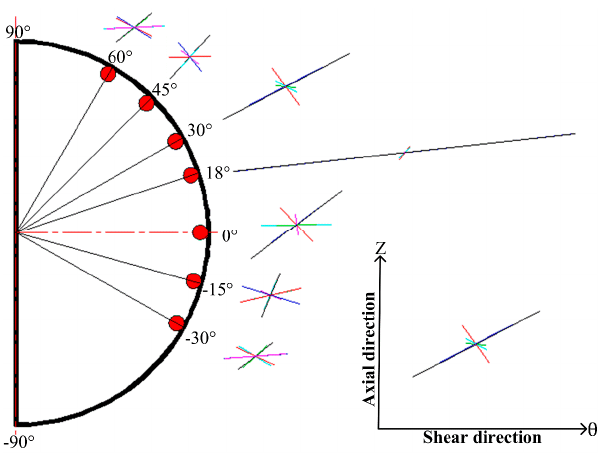
Figure 5. Slip traces of various tangential positions on the surface of the initial (001) aluminum single crystal after N = 1/12 turn of HPT deformation.